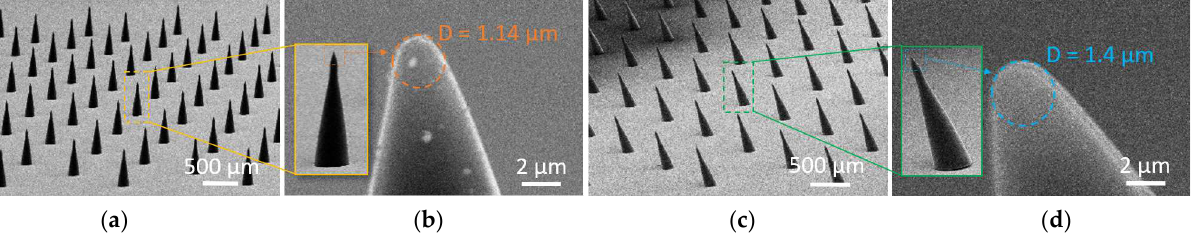
Figure 5. Straight and inclined first bell-tip microneedles arrays (180 units). ( a ) Straight microneedles array with diameter and height of 150 µm and 460 µm. ( b ) Zoomed-in view at the straight microneedle tip with tip diameter of 1.14 µm. ( c ) Inclined microneedles array with diameter, height, and inclined angle of 150 µm, 450 µm, and 20°. ( d ) Zoomed-in view at the inclined microneedle tip with tip diameter of 1.4 µm.